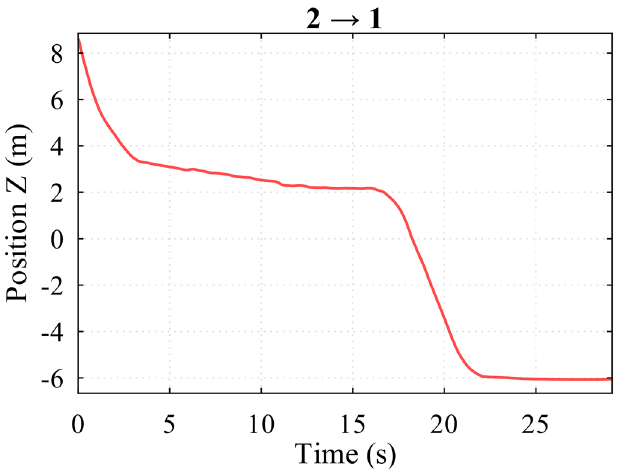
Figure 5. The way of the spreader in the dimension of the Z-axis: Example A.